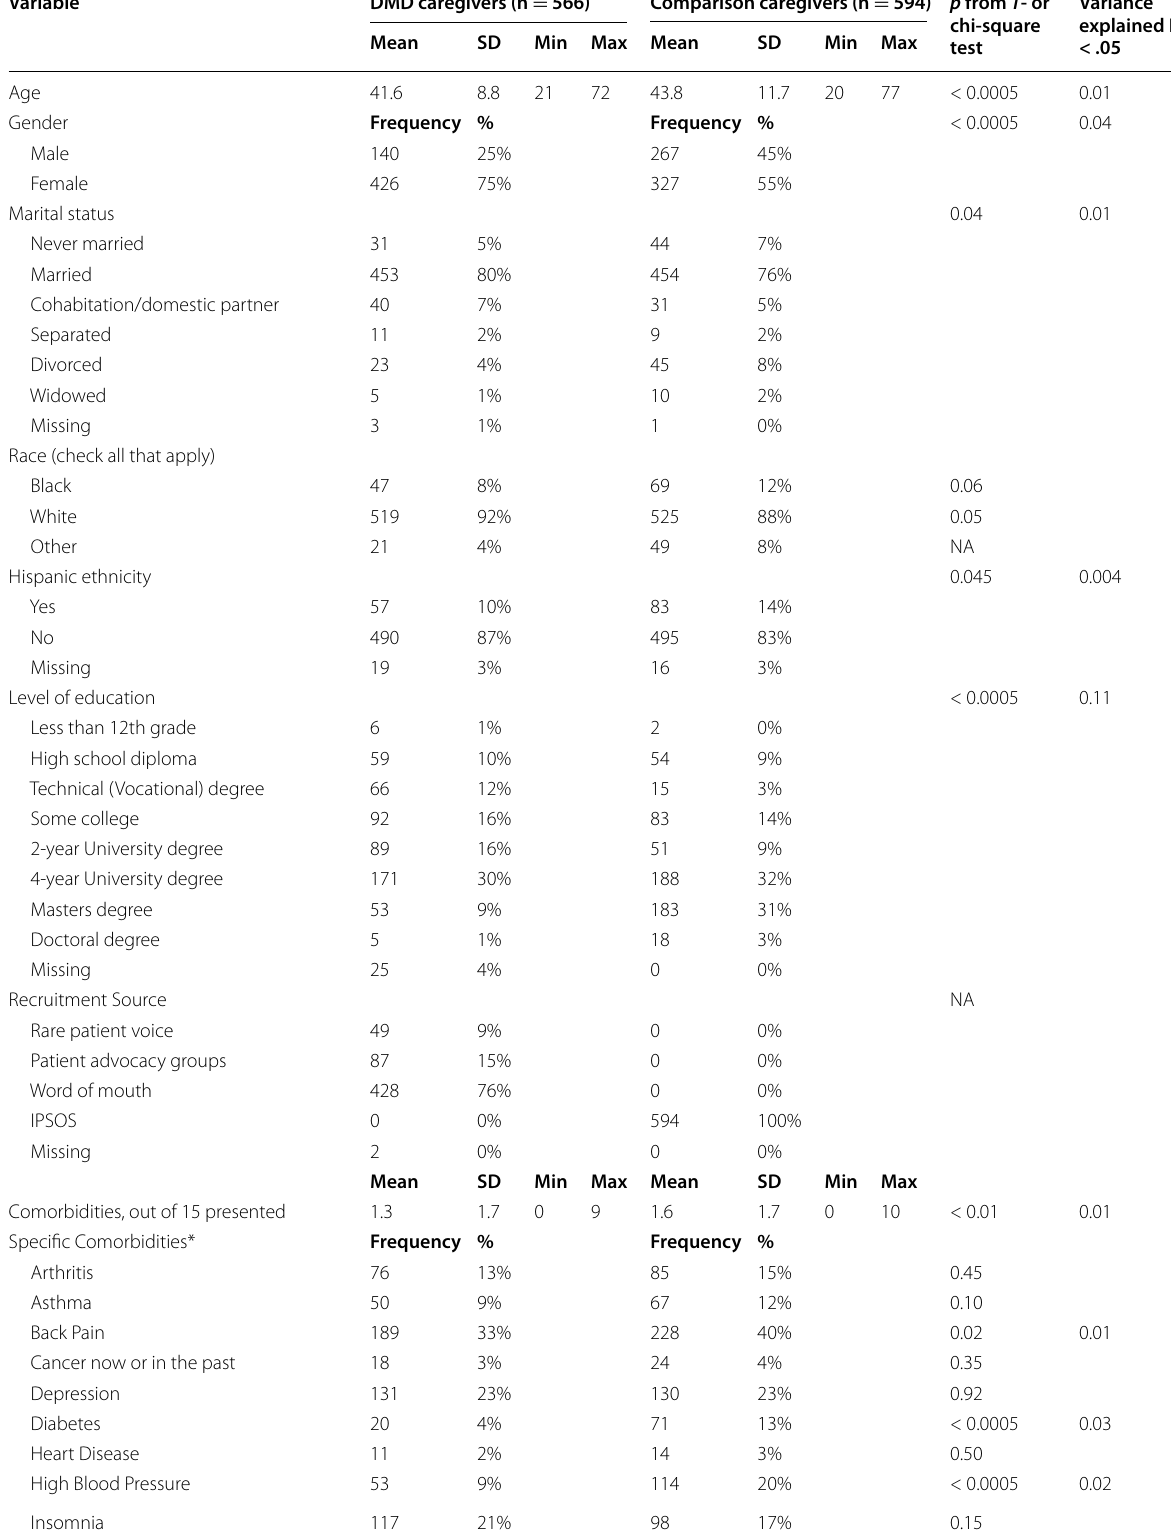
Table 1 Descriptive Statistics of